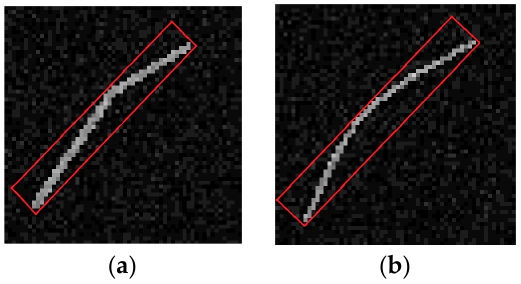
Figure 6. False detections of line features. ( a ) is polyline edge; ( b ) is curve edge.